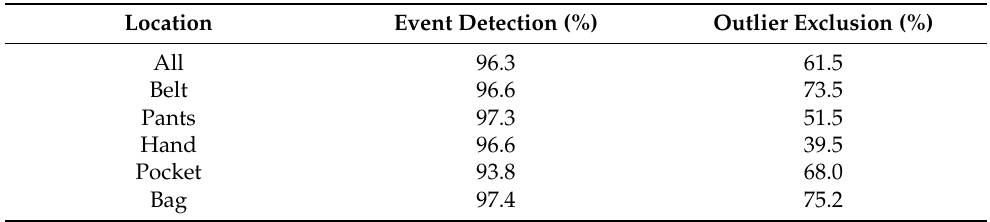
Table 1. The data that remained after each of the two main steps in the gait analysis protocol. Using Belt as an example, 96.6% of the initial data remained after event detection, and 73.5% remained after outlier exclusion. Location Event Detection (%) Outlier Exclusion